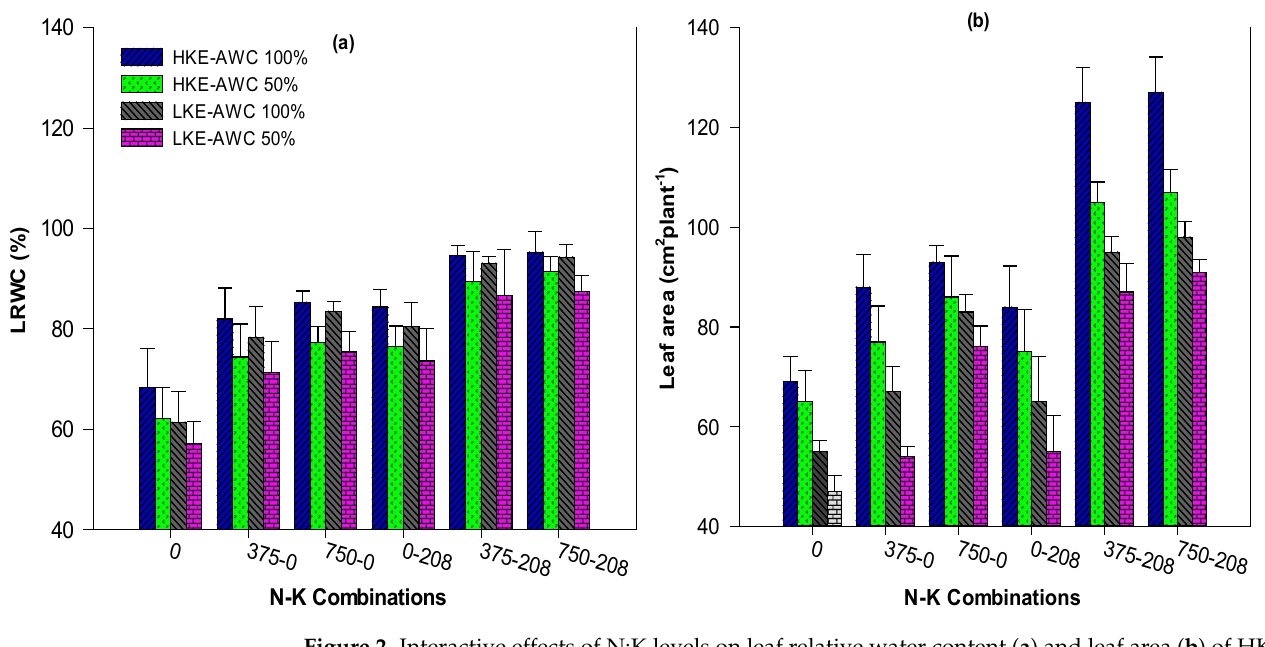
Figure 2. Interactive effects of N:K levels on leaf relative water content ( a ) and leaf area ( b ) of HKE and LKE cultivars of cotton at AWC 100% and AWC 50% irrigation levels (only the effect of NKx MRx Cv is given). Error bars are showing the standard error of mean.